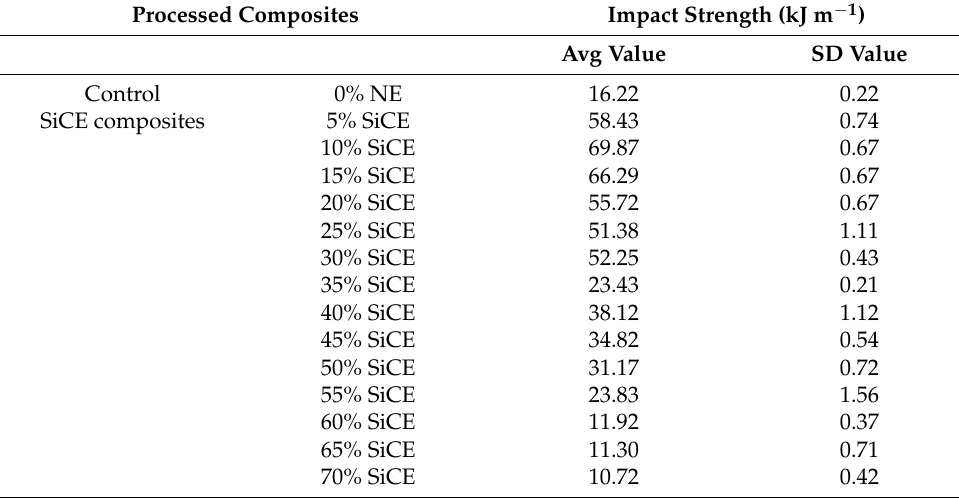
Table 1. Results of tensile tests for all processed epoxy matrix composites.